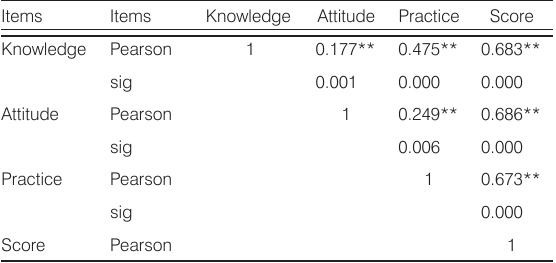
Table 10. Correlation analysis between each dimension and the questionnaire ( N =